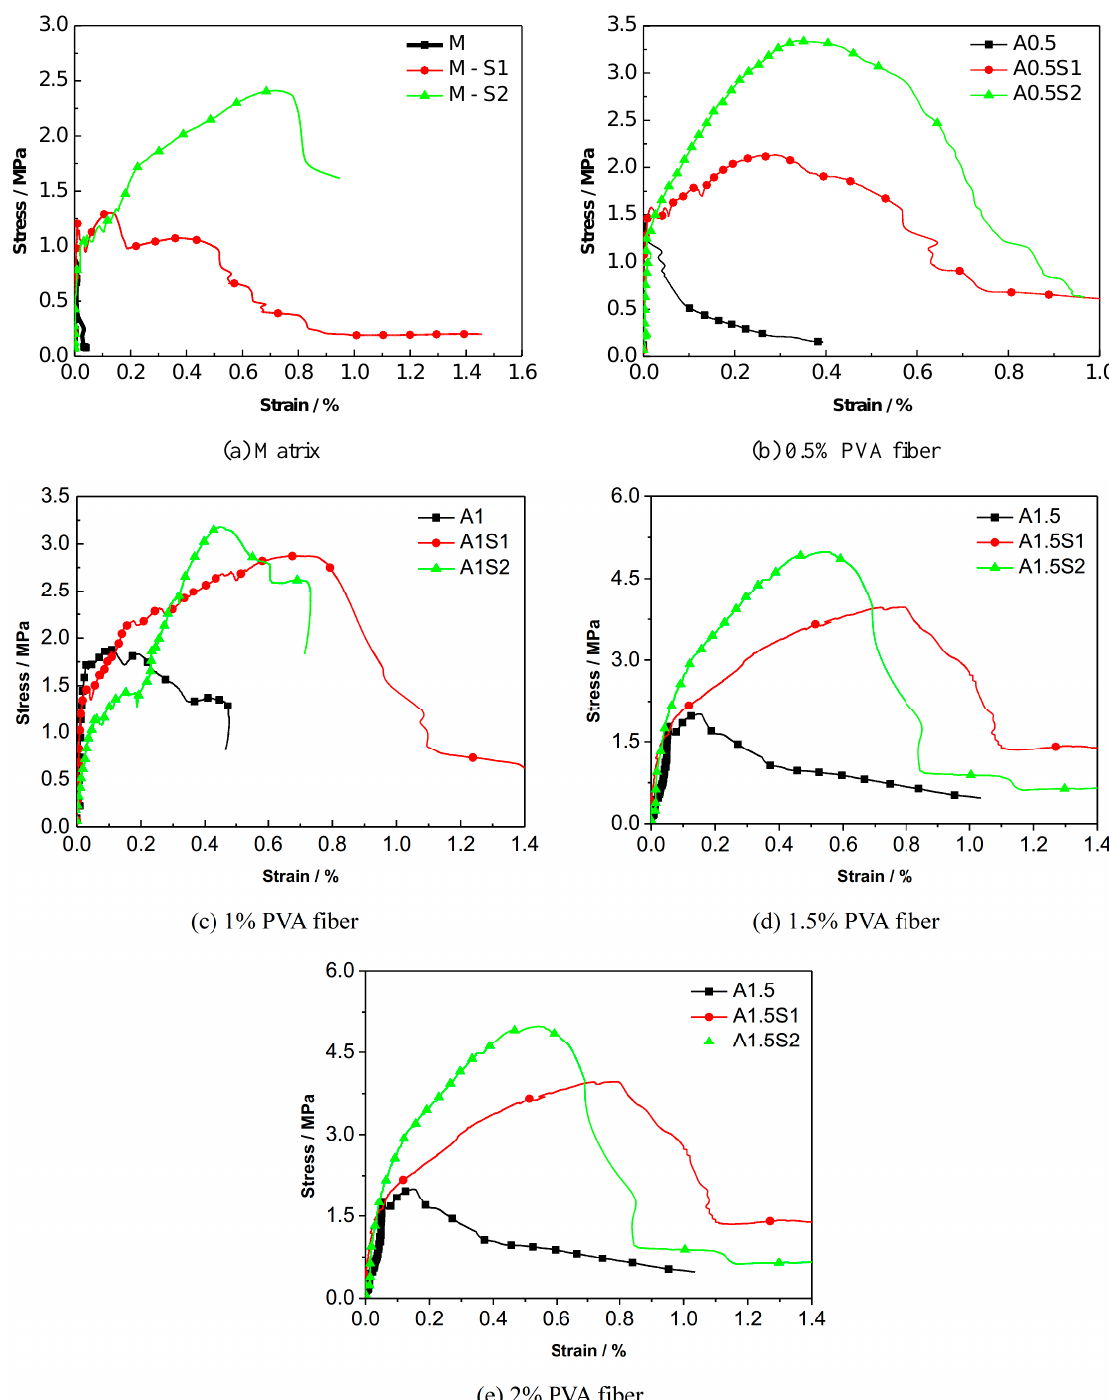
Fig.5 Post-failure specimens of steel grid-PVA fiber reinforced ECC with multiple cracks 187